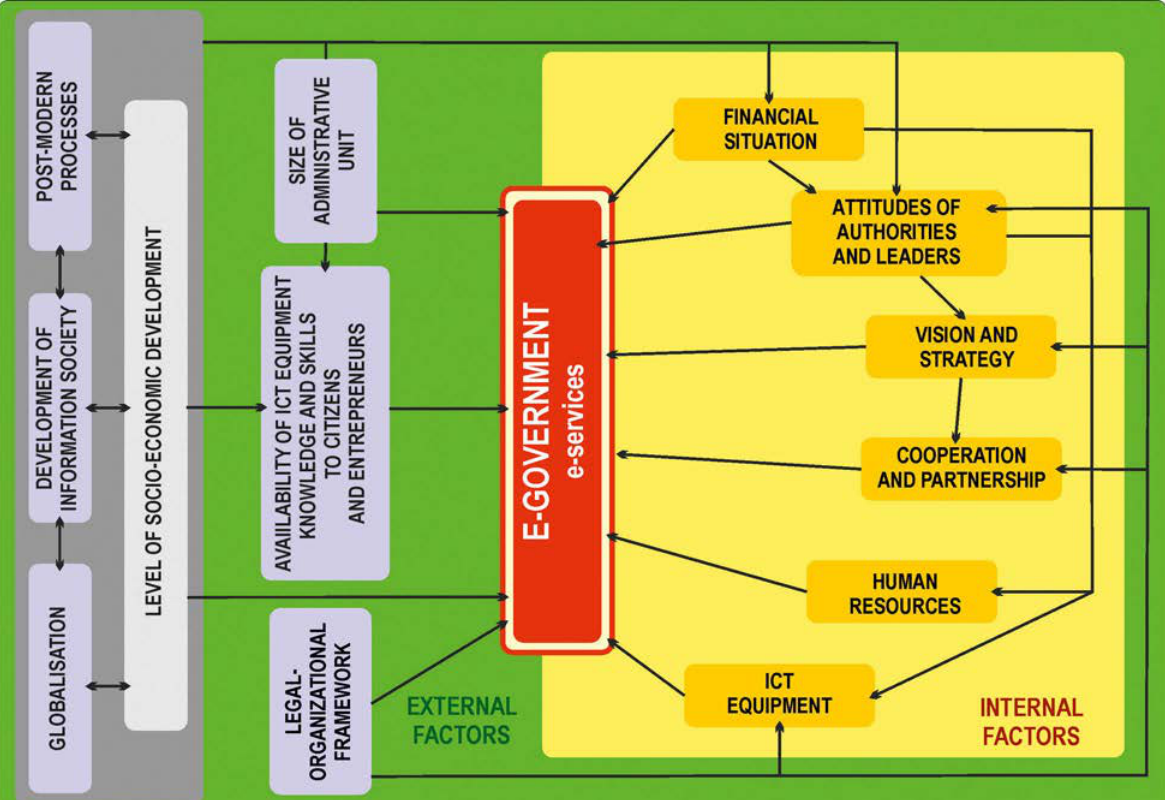
Fig. 1. Model of factors of local e-government development Source: own